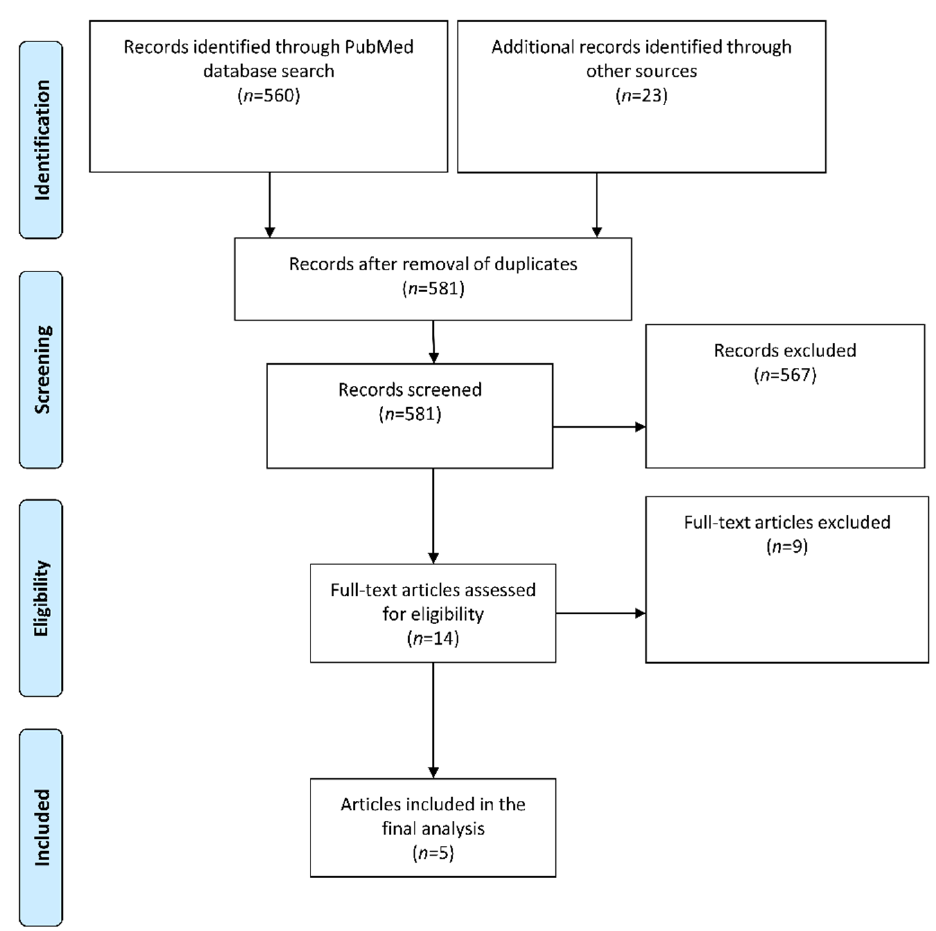
Figure 3. Flow chart of the systematic search process of the literature.